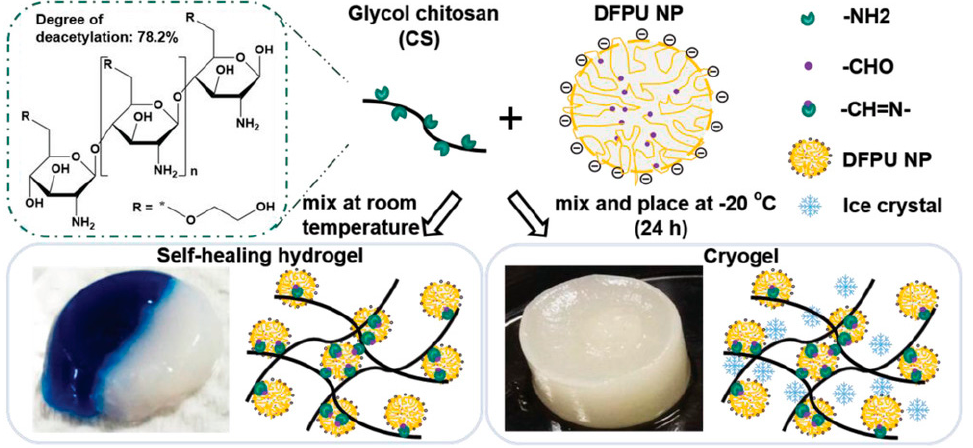
Figure 4. Schematic representation of the simple process to form a self-healing hydrogel or cryogel. (Adapted with permission from Reference [113]).